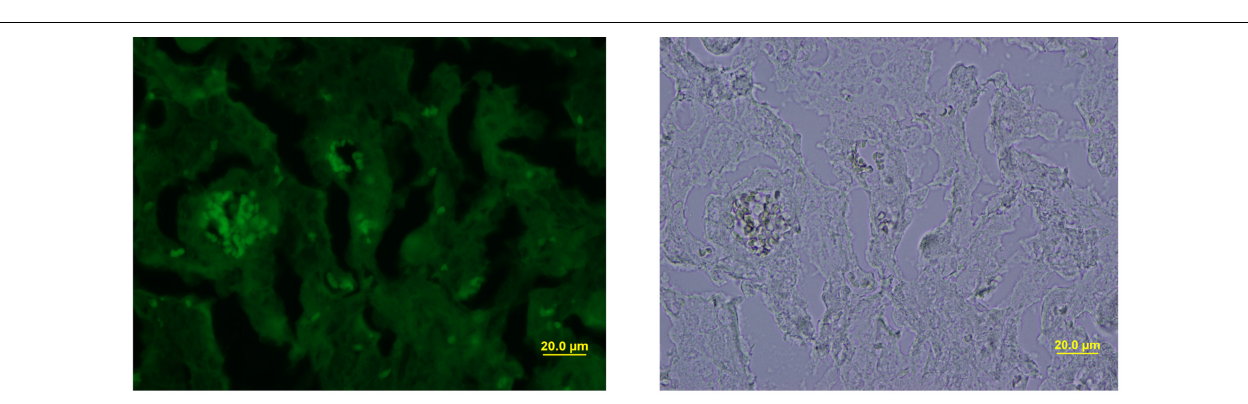
Frontiers in Microbiology |